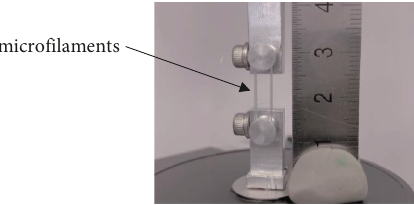
Figure 2: Filament arrangement in grip system used for tensile